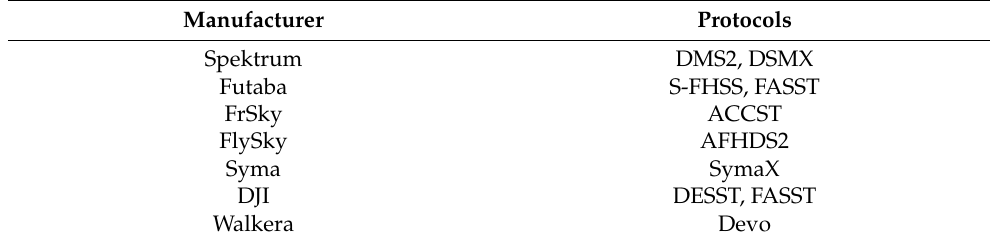
Table 2. UAV manufacturers and their